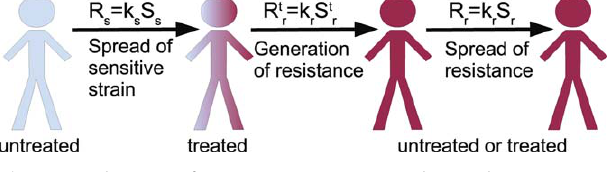
Figure 3. Schematic of Resistance Generation and Spread